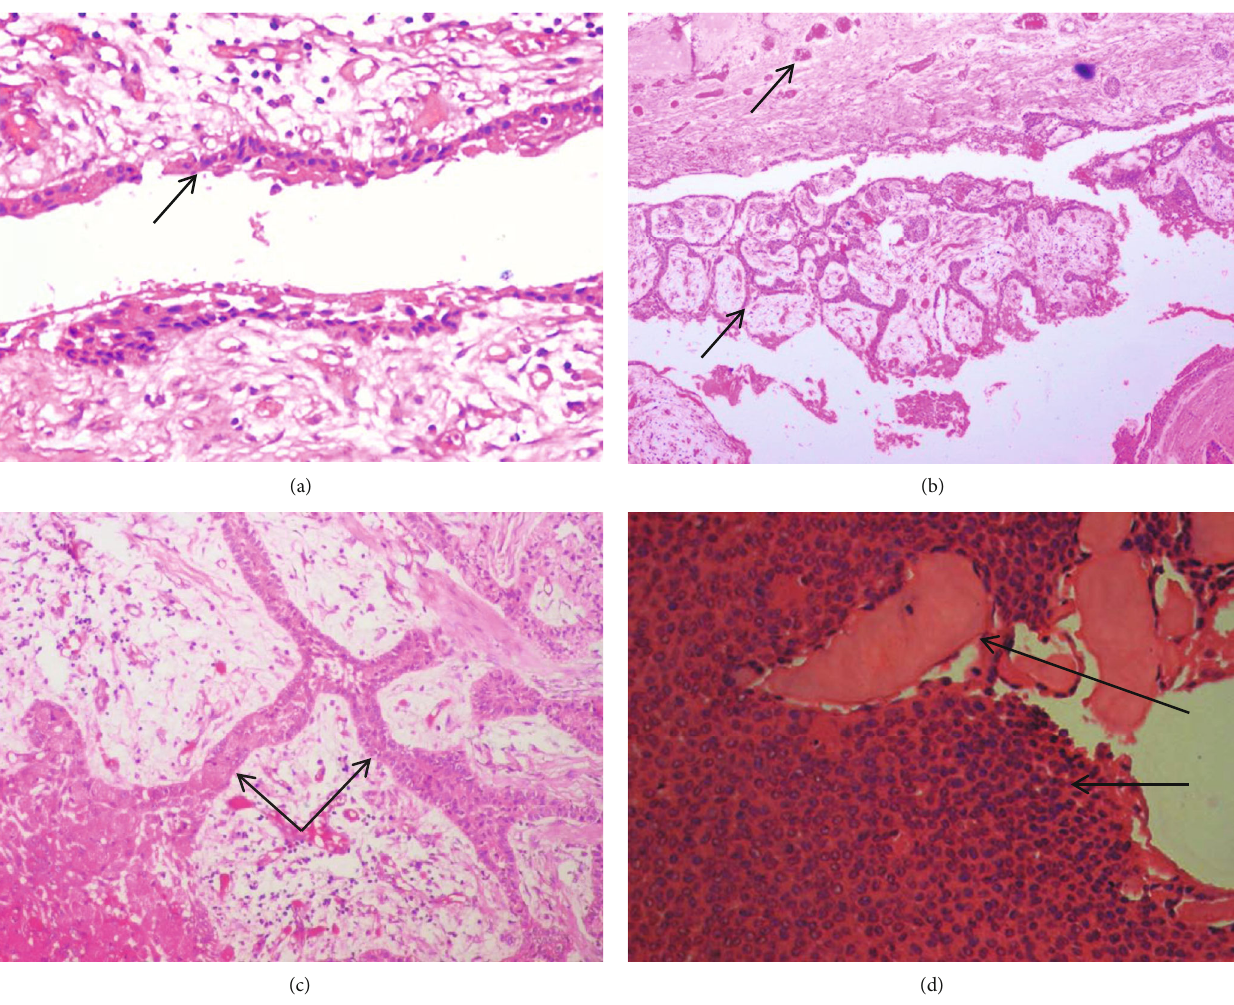
Figure 2: (a) H&E-stained section showing the cystic lumen lined by a thin nonkeratinized strati fi ed squamous epithelium with columnar basal cells at focal areas ( × 100). (b) H&E-stained section showing epithelial proliferations into both the cystic lumen and the connective tissue wall ( × 40). (c) H&E-stained section showing odontogenic epithelial cells arranged in interconnecting strands and sheets with granular cells located centrally ( × 100). (d) H&E-stained section showing darkly stained polygonal cells arranged in sheets with homogenous eosinophilic deposits resembling CEOT-like